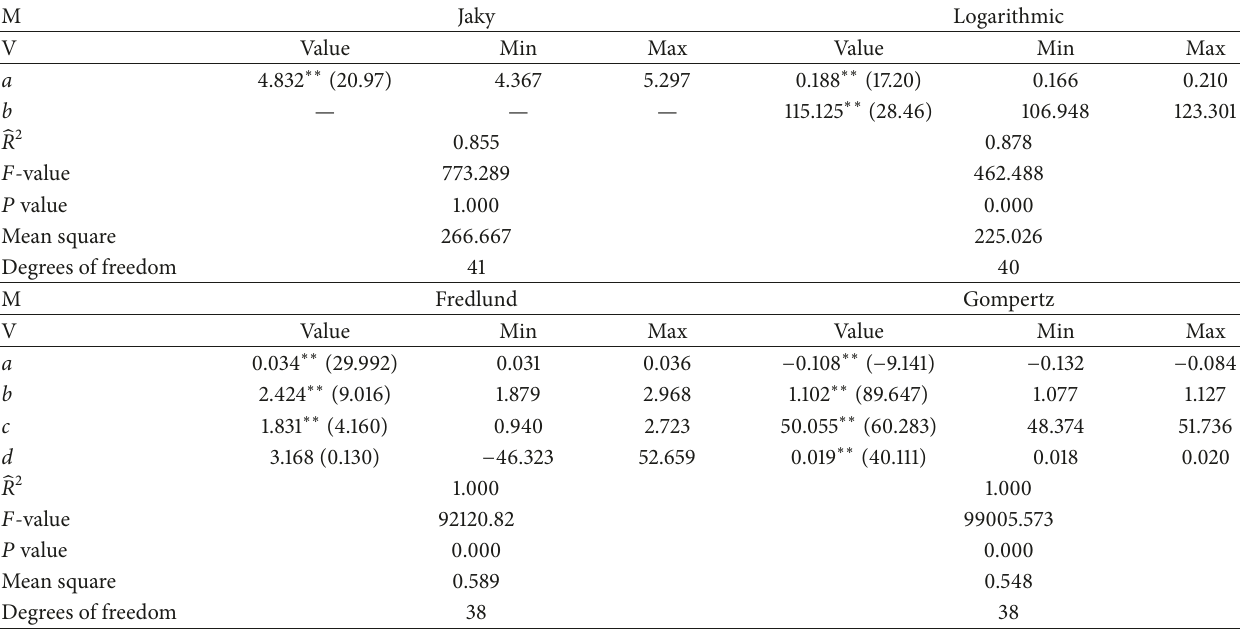
Table 2: Fitting parameters of G-7 by laser diffraction technique.